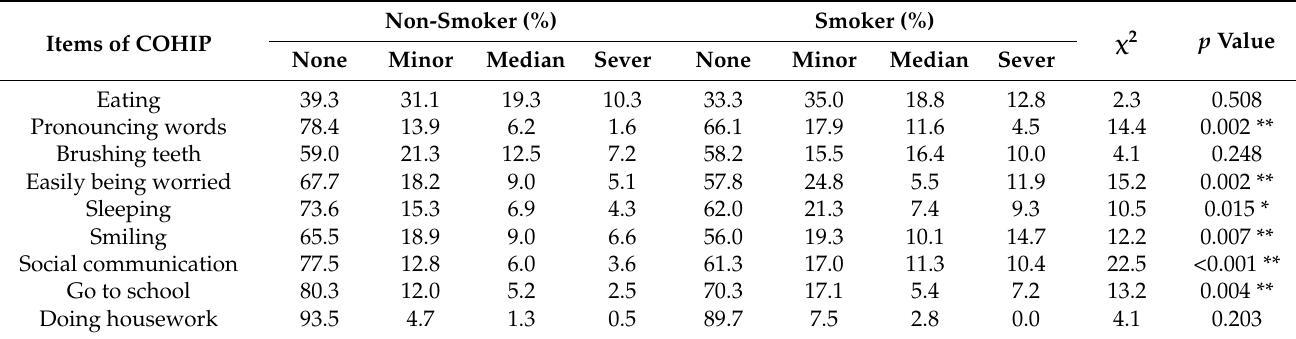
Table 5. Frequency distribution of responses for the items of